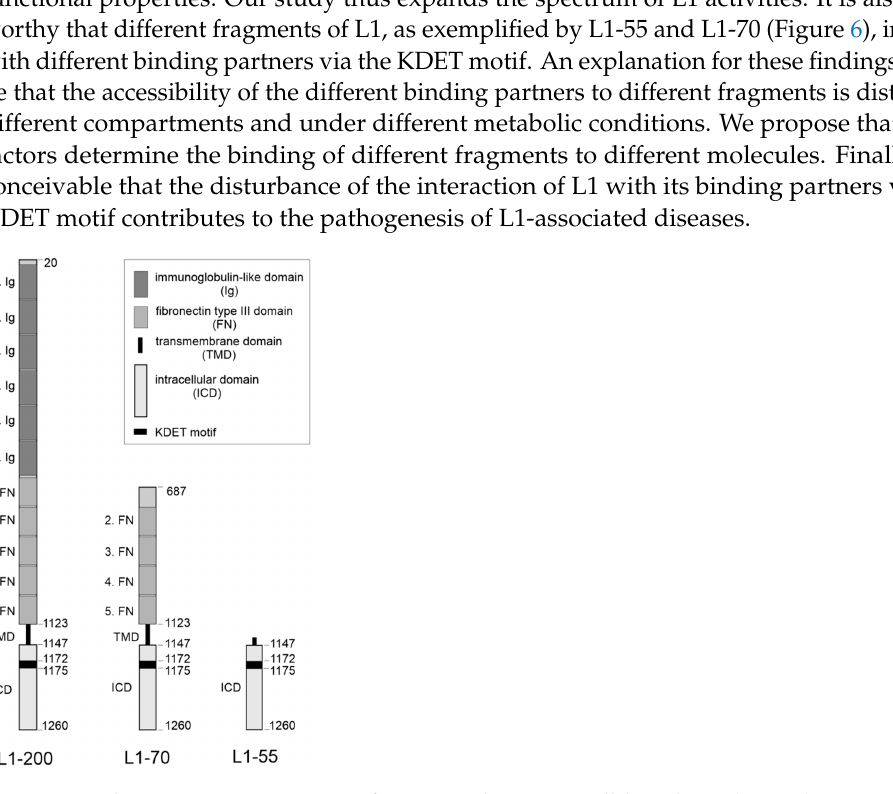
Figure 6. Schematic representation of L1-55 and L1-70. Full-length L1 (L1-200) consists of an extra- cellular portion with 6 Ig-like (Ig) and 5 FNIII (FN) domains, a transmembrane domain (TMD), and an intracellular domain (ICD), which contains the KDET motif. L1-200 is cleaved by a proteolytically active myelin basic protein in the first FNIII domain at position 687, leading to the generation of L1-70, which comprises part of the first FNIII domain, the second, third, fourth, and fifth FNIII do- mains, as well as the TMD and ICD with the KDET motif. Sequential cleavage of L1-200 by metallo-